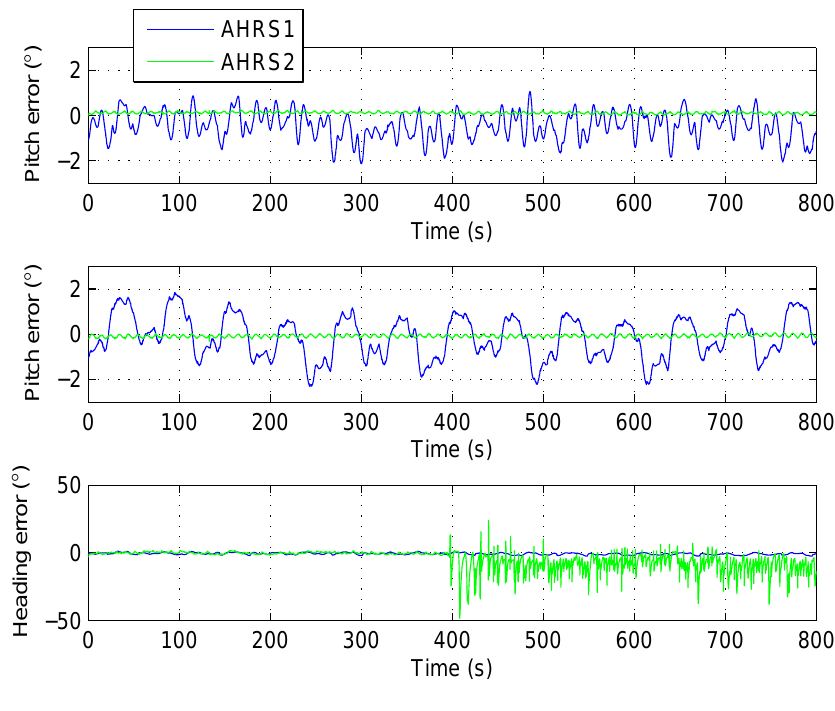
Figure 15. Attitude and heading errors comparison between AHRS1 and AHRS2. Magnetic interference is added after 400